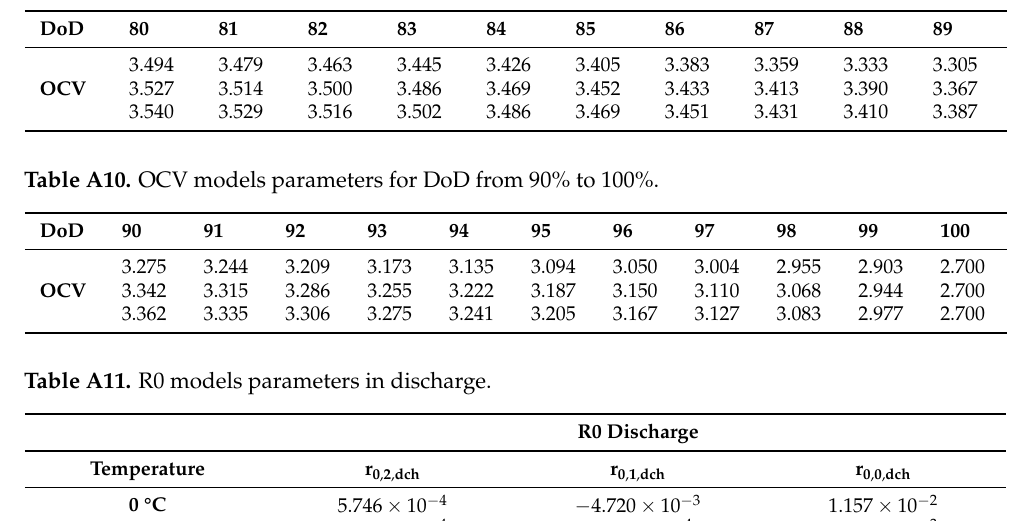
Table A9. OCV models parameters for DoD from 80% to 89%.